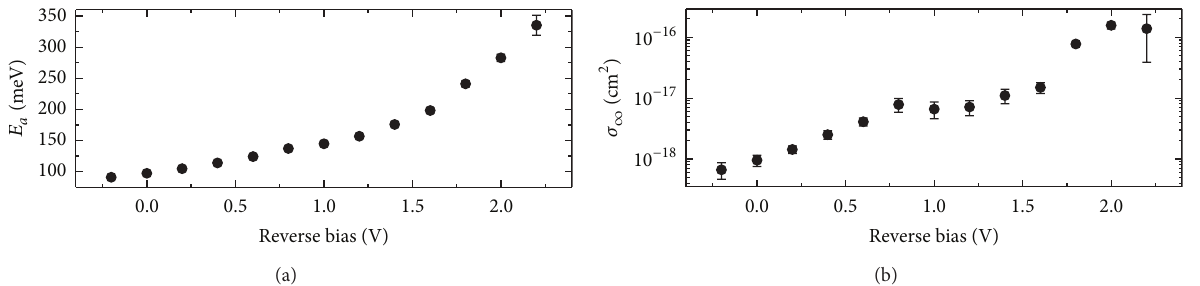
Figure 5: (a) Activation energies and (b) apparent capture cross sections for holes derived from the charge-selective DLTS spectra.